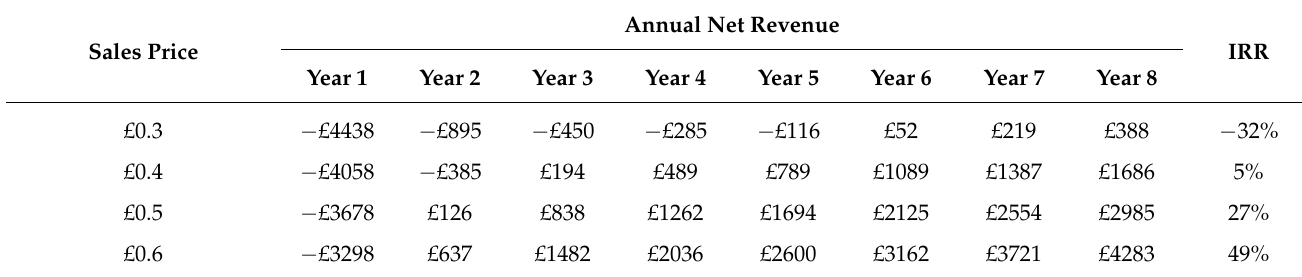
Table 22. IRR analysis of County Durham (one charger) in